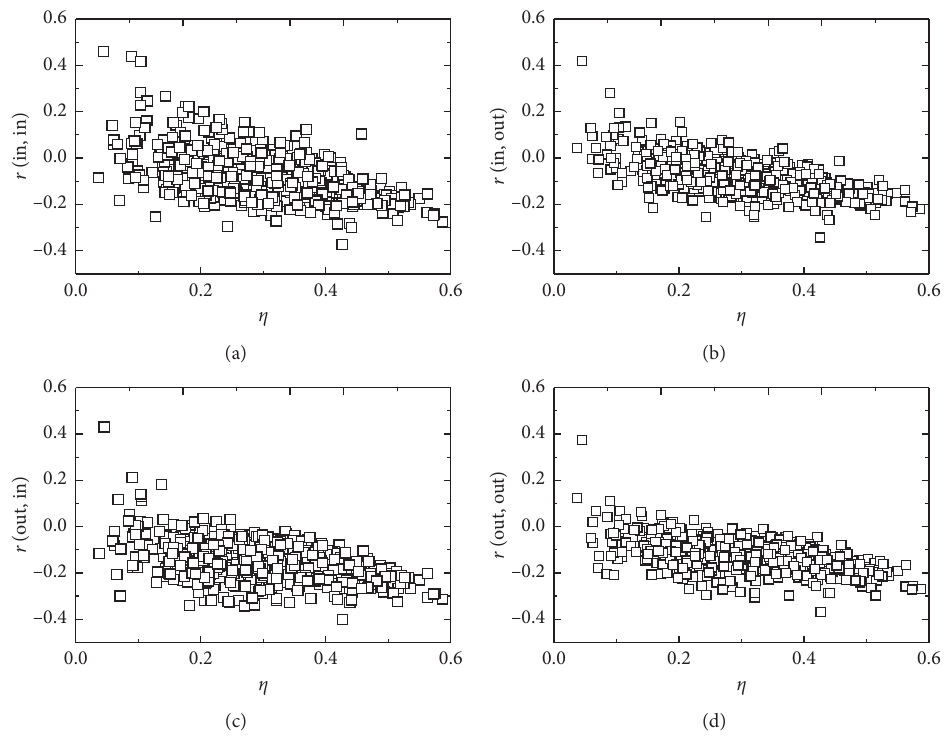
Figure 6: The four types of degree-degree correlations in nested networks. (a) r (in, in) means in-degree-in-degree correlation; (b) r (in, out) means in-degree-out-degree correlation; (c) r (out, in) means out-degree-in-degree correlation; (d) r (out, out) means out-degree-out- degree